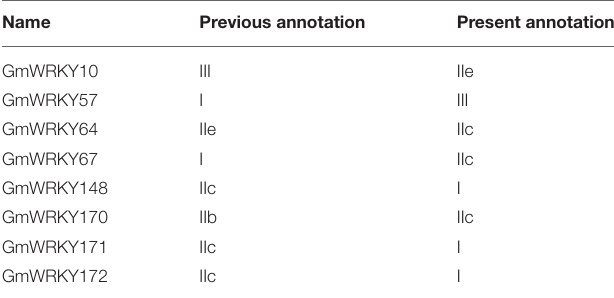
TABLE 2 | Annotation revised in GmWRKY genes.